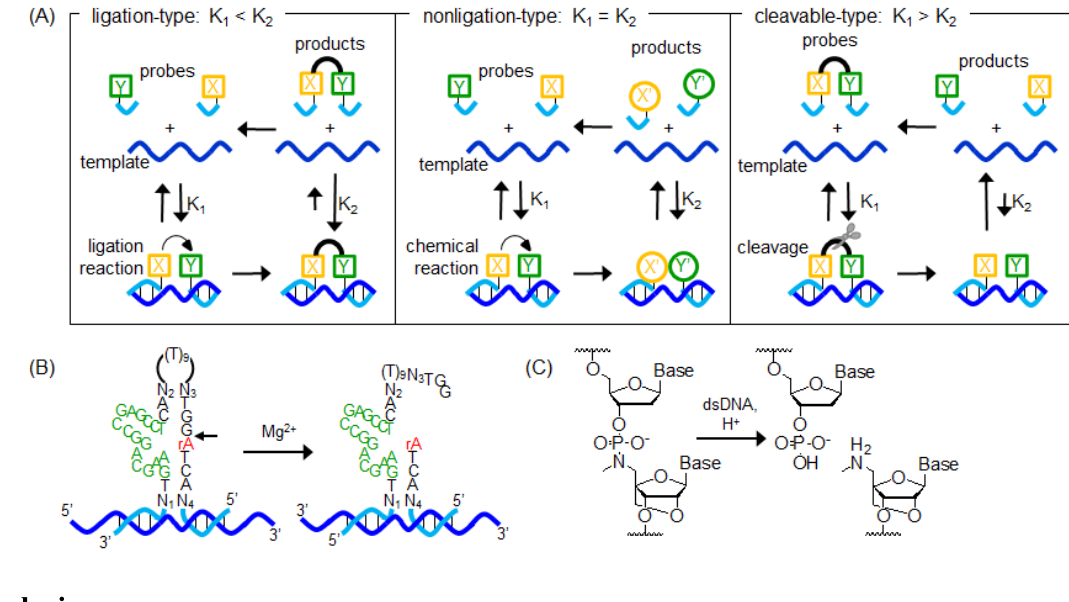
Figure 9. Schematic representation of ( A ) the thermodynamic cycle of templated reaction; ( B ) the self-cleaving DNAzyme; and ( C ) the cleavage of a P3' → N5' phosphoramidate